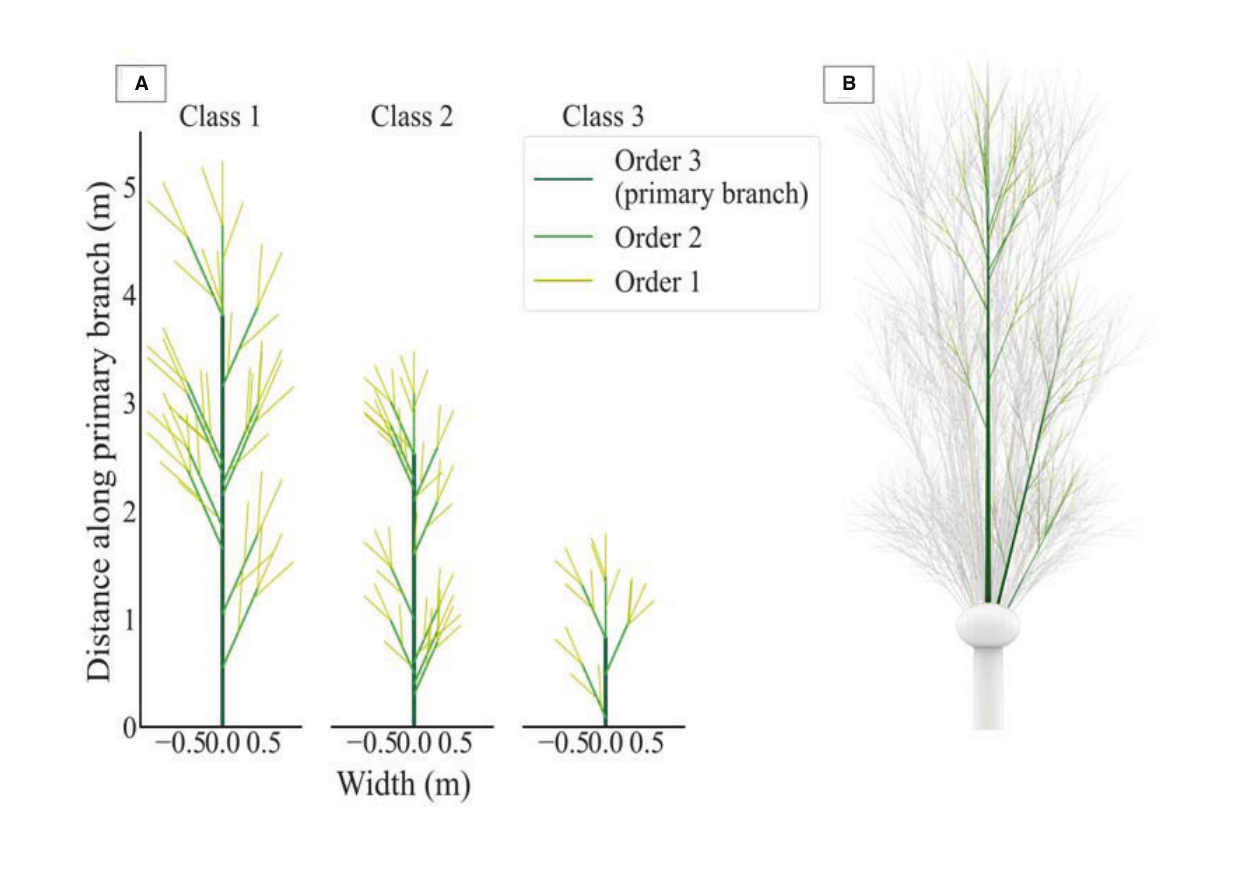
FIGURE 9 | (A) An example of 3 simulated branch classes, (B) impression of one simulated tree which consists of a trunk, a knot and multiple branches of each